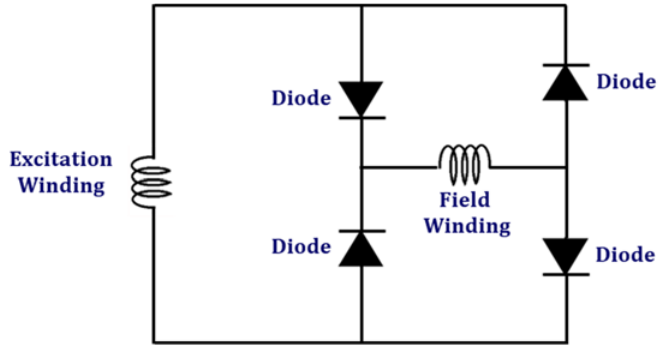
Figure 2. Connection of field winding and excitations winding of rotor via a bridge rectifier.